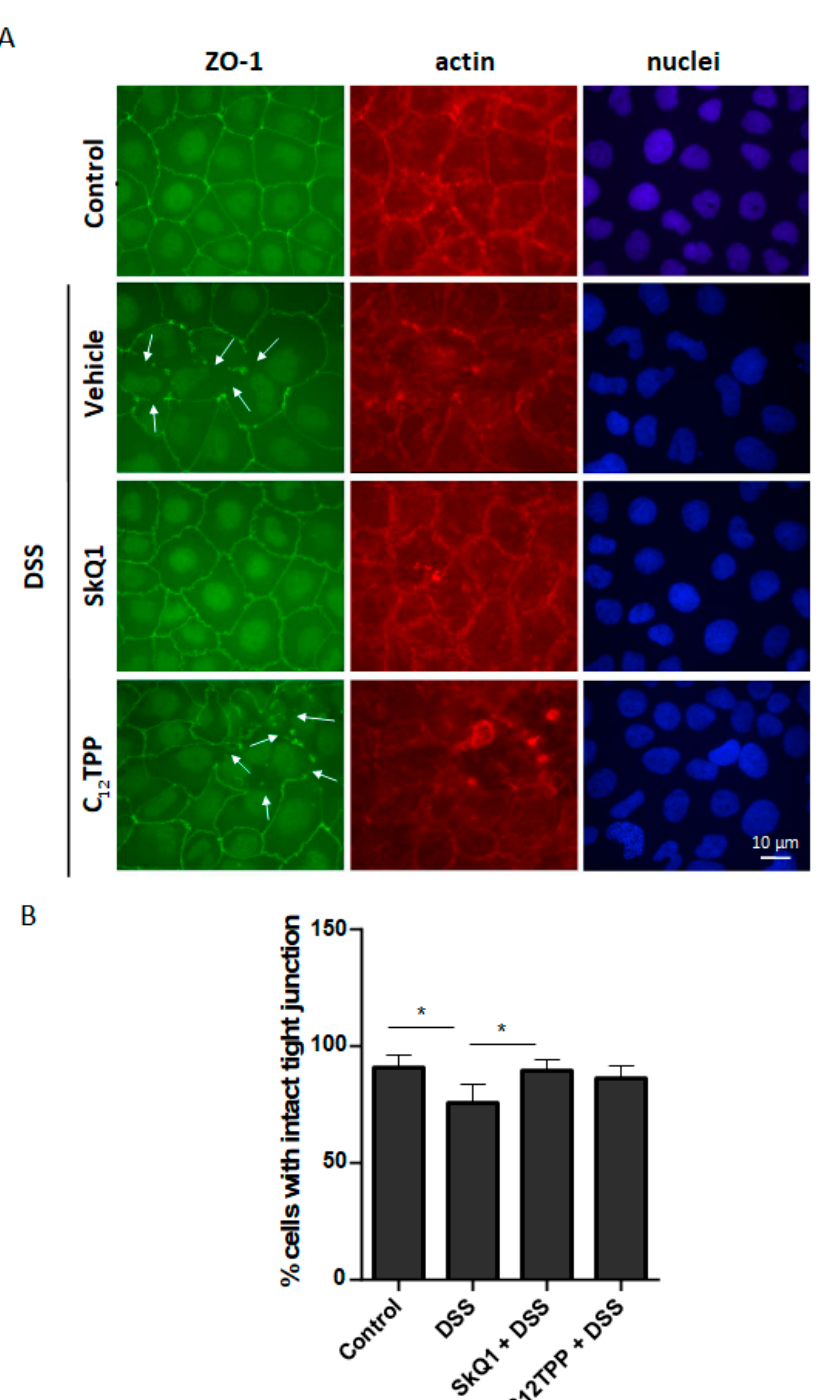
Figure 4. Effect of SkQ1 and C 12 TPP on tight junction disruption in Caco-2 cells after DSS exposure. ( A ) Immunofluorescence of the tight junction (green), actin cytoskeleton (red), and nuclei (blue) in cells. After treatment with 2 nM of SkQ1 or C 12 TPP for 48 h, cells were treated with 2% DSS for 2 days. The cells were fixed with 2% paraformaldehyde and stained with anti-ZO-1 antibody (ZO-1) with phalloidin-TRITC (actin), and Hoechst 33342 (nuclei). ( B ) The percentage of cells with intact tight junctions. The arrows indicate the disassembly of tight junctions (lack of ZO-1 between cells). Between 500 to 600 cells were analyzed in four independent experiments. Results are expressed as mean ± SD. * p < 0.05 as compared with the DSS-treated cells.